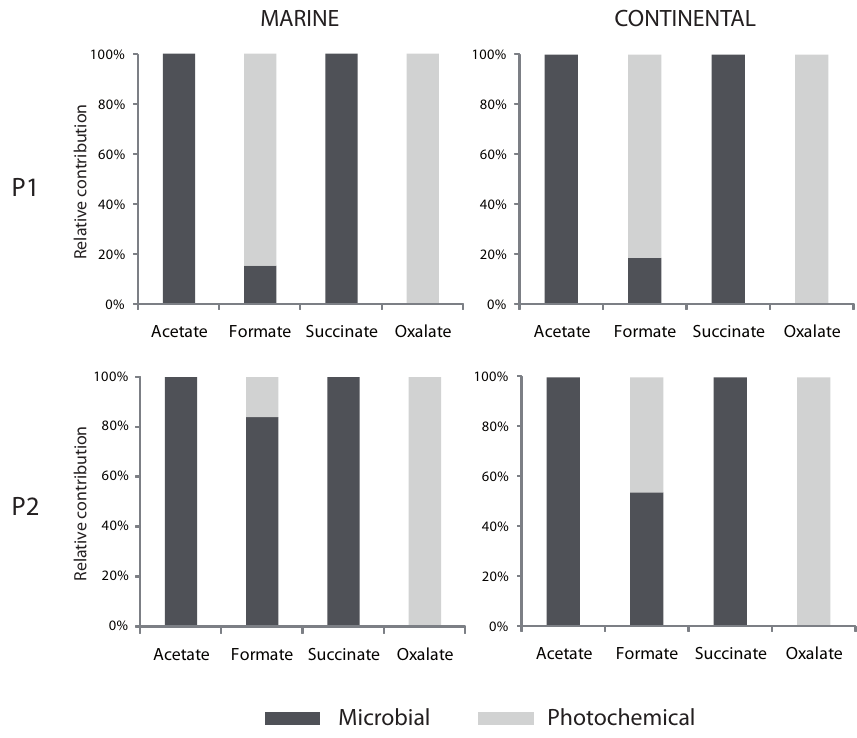
Fig. 2. Microbial and photochemical relative contributions to the degradation of carboxylic compounds in “marine” (left side) and “conti- nental” (right side) artificial cloud media at 17 ◦ C and 5 ◦ C. P1 and P2 correspond to the 2 irradiation setups. This figure is based on the experimental photodegradation and biodegradation rates shown in Table